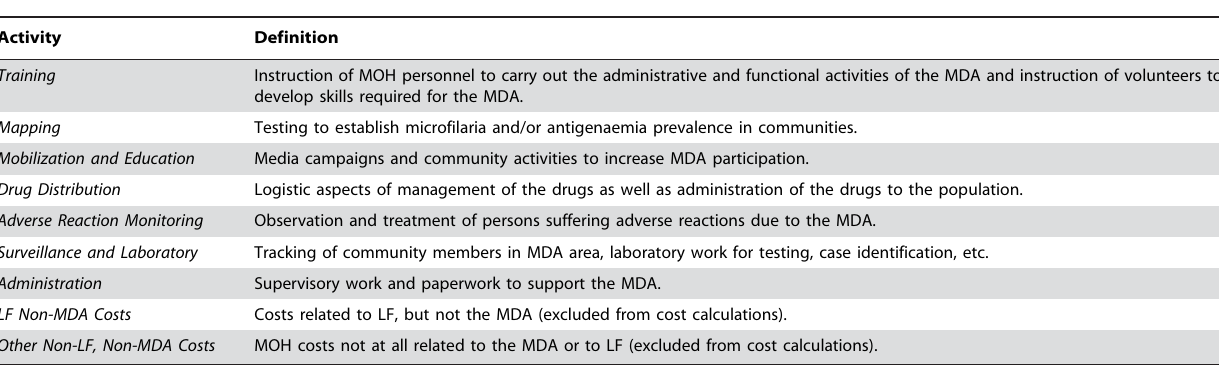
Table 2. MDA Activities and Other Cost Categories.